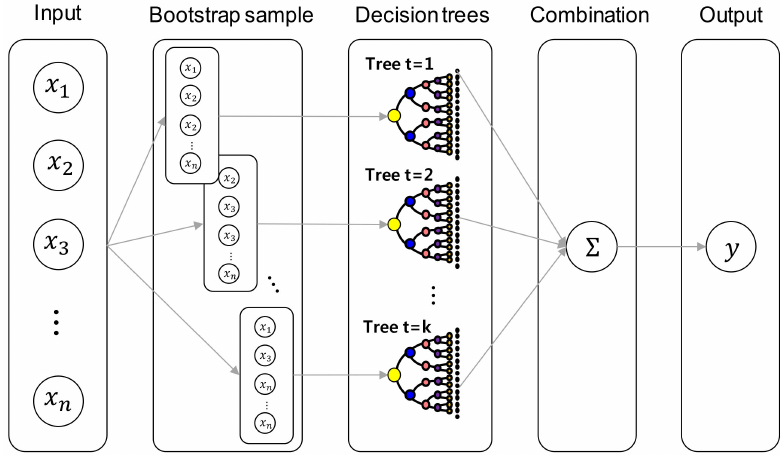
Figure 3. The basic structure of the Random Forest (RF)